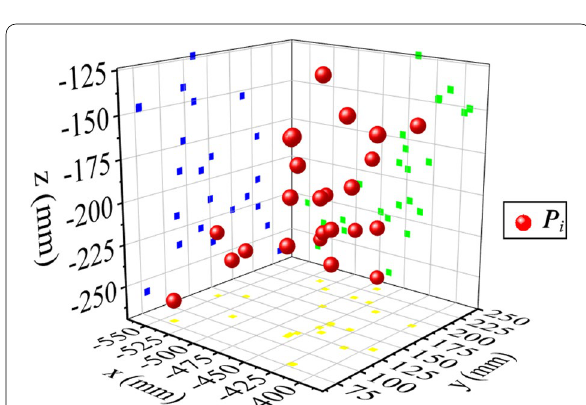
Figure 9 25 initial pose points for system calibration in C b (The small blue, green and yellow squares represent the projection of P i on the